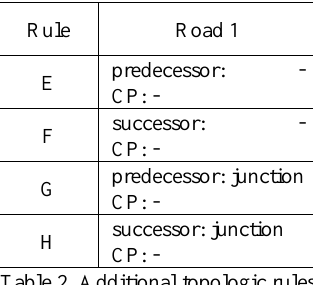
Table 2. Additional topologic rules